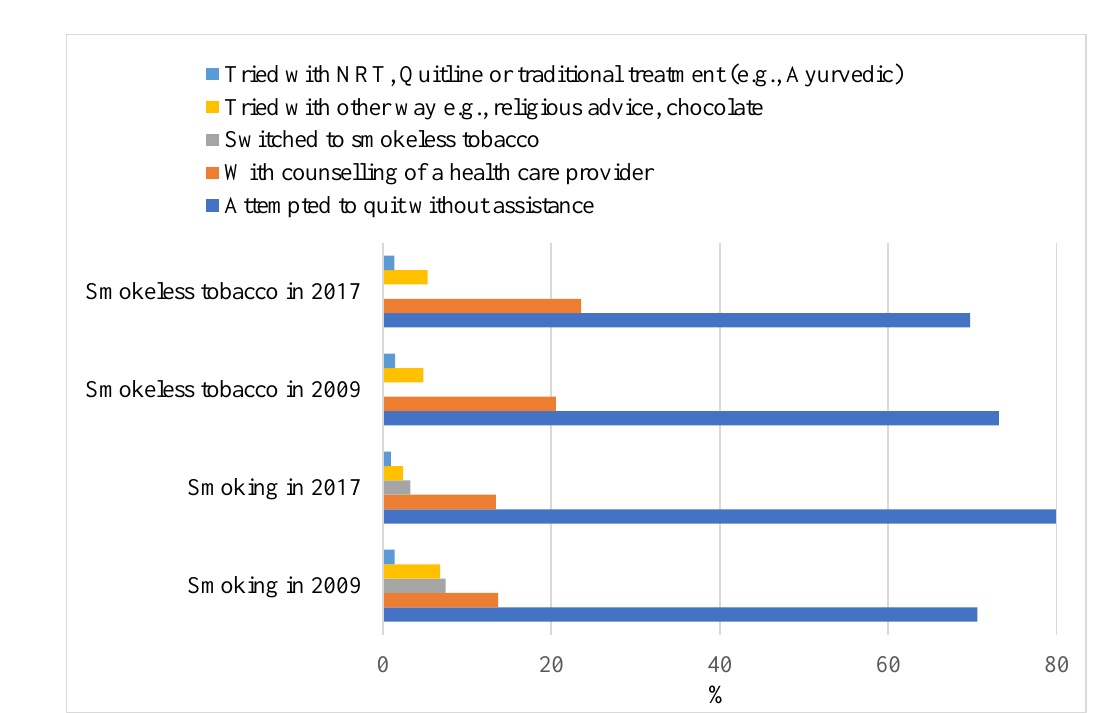
Figure 3. Various methods used by the tobacco users who attempted to quit in the past 12 months.